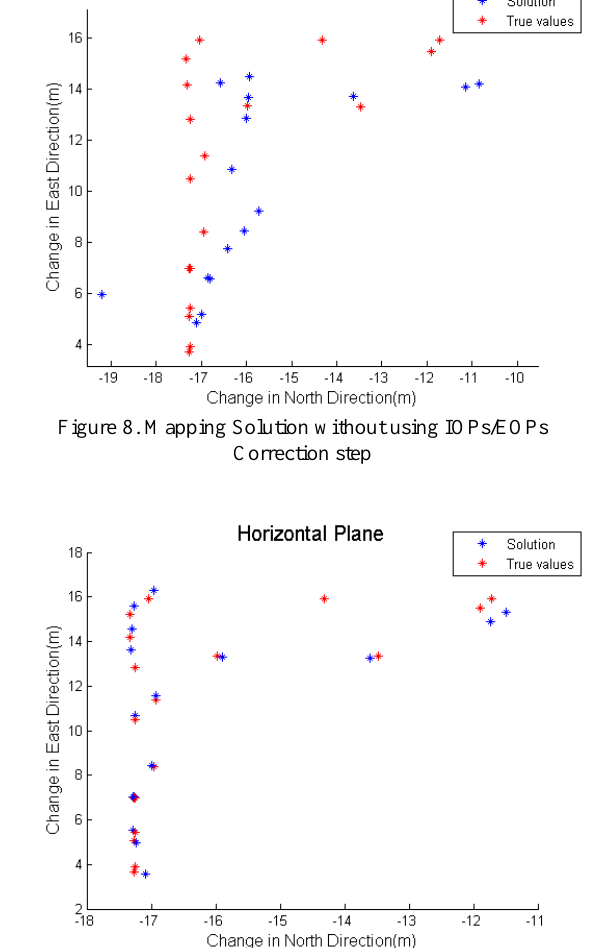
Figure 9. Mapping Solution using IOPs/EOPs Correction step